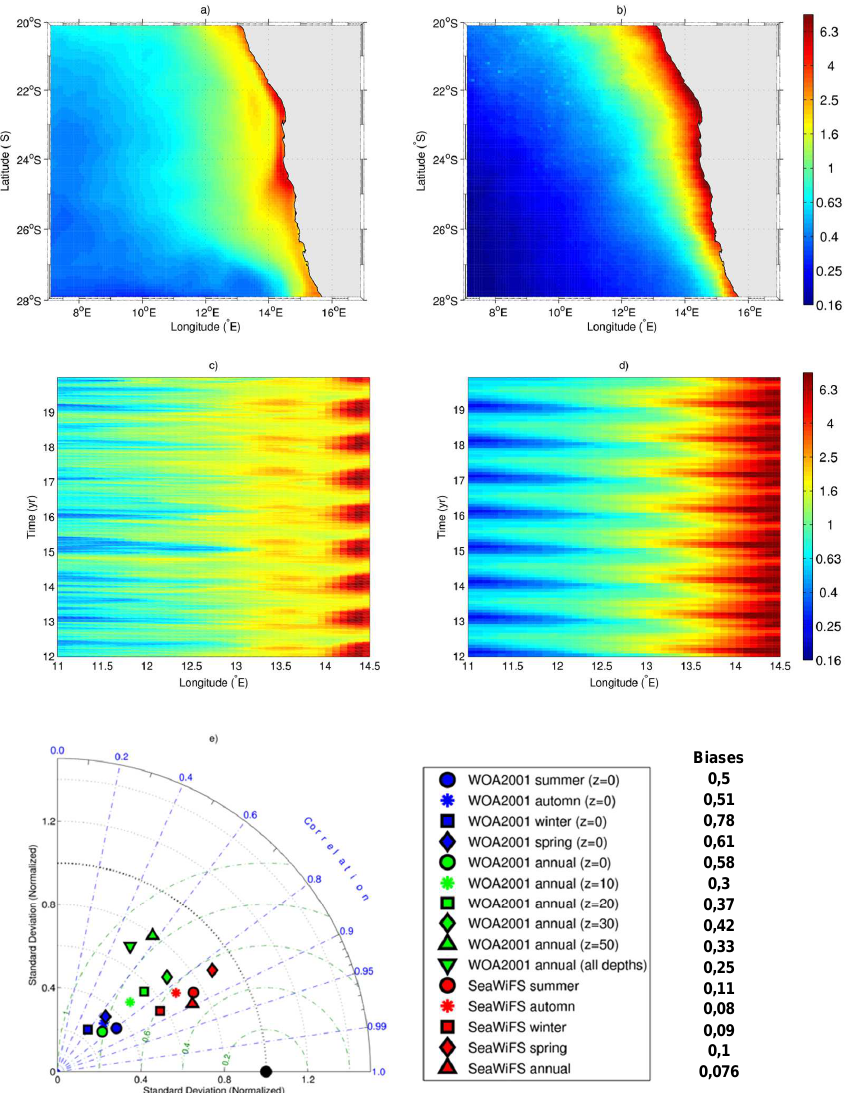
Fig. 7. 8yr mean and times series (last 8yr of simulation averaged between 22–24 ◦ S) of logarithm of surface chlorophyll a concentrations (mg Chlm − 3 ) from the coupled model (a, c) and SeaWiFS climatology (b, d) . Taylor diagram for logarithm of chlorophyll a concentrations (e) . See legend of Fig. 4 for details. Biases between the modeled fields and compared data have been added to the right of the legend.